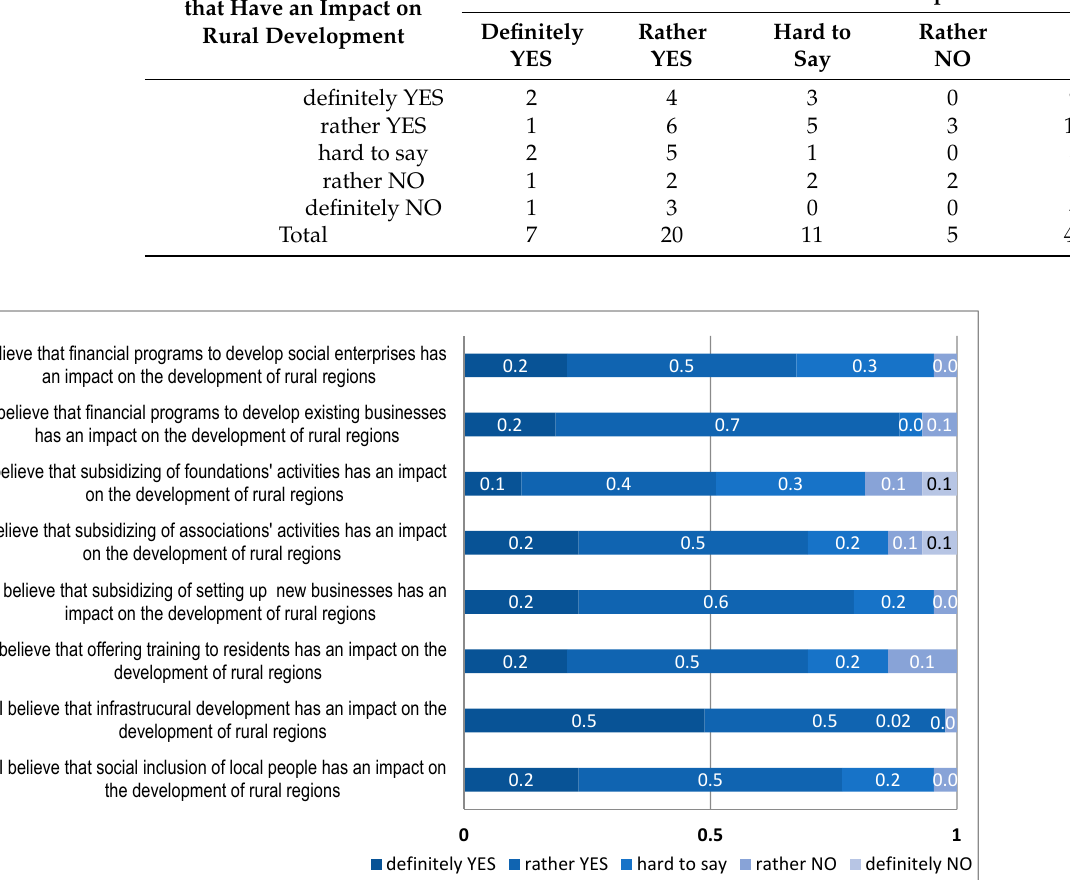
Figure 5. Factors determining rural development.